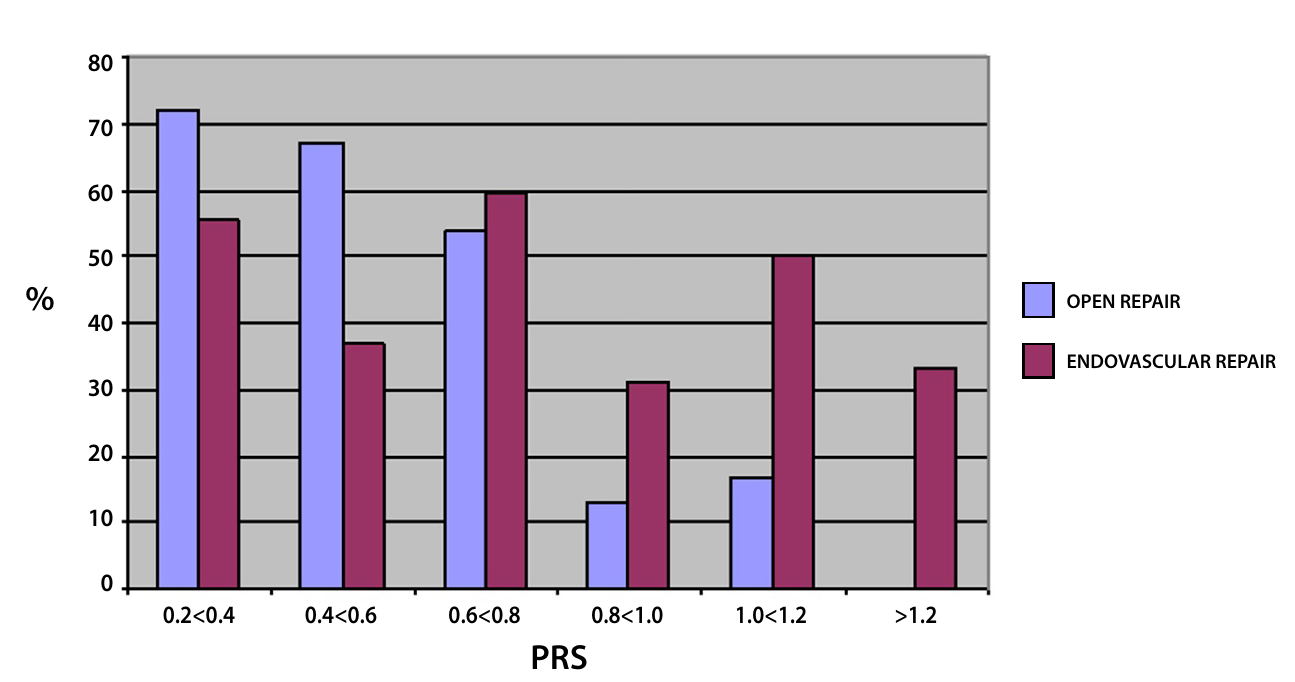
Fig. 3 - Percentage of patients that did not present postoperative complications in the OR and EVAR groups, according to PRS.